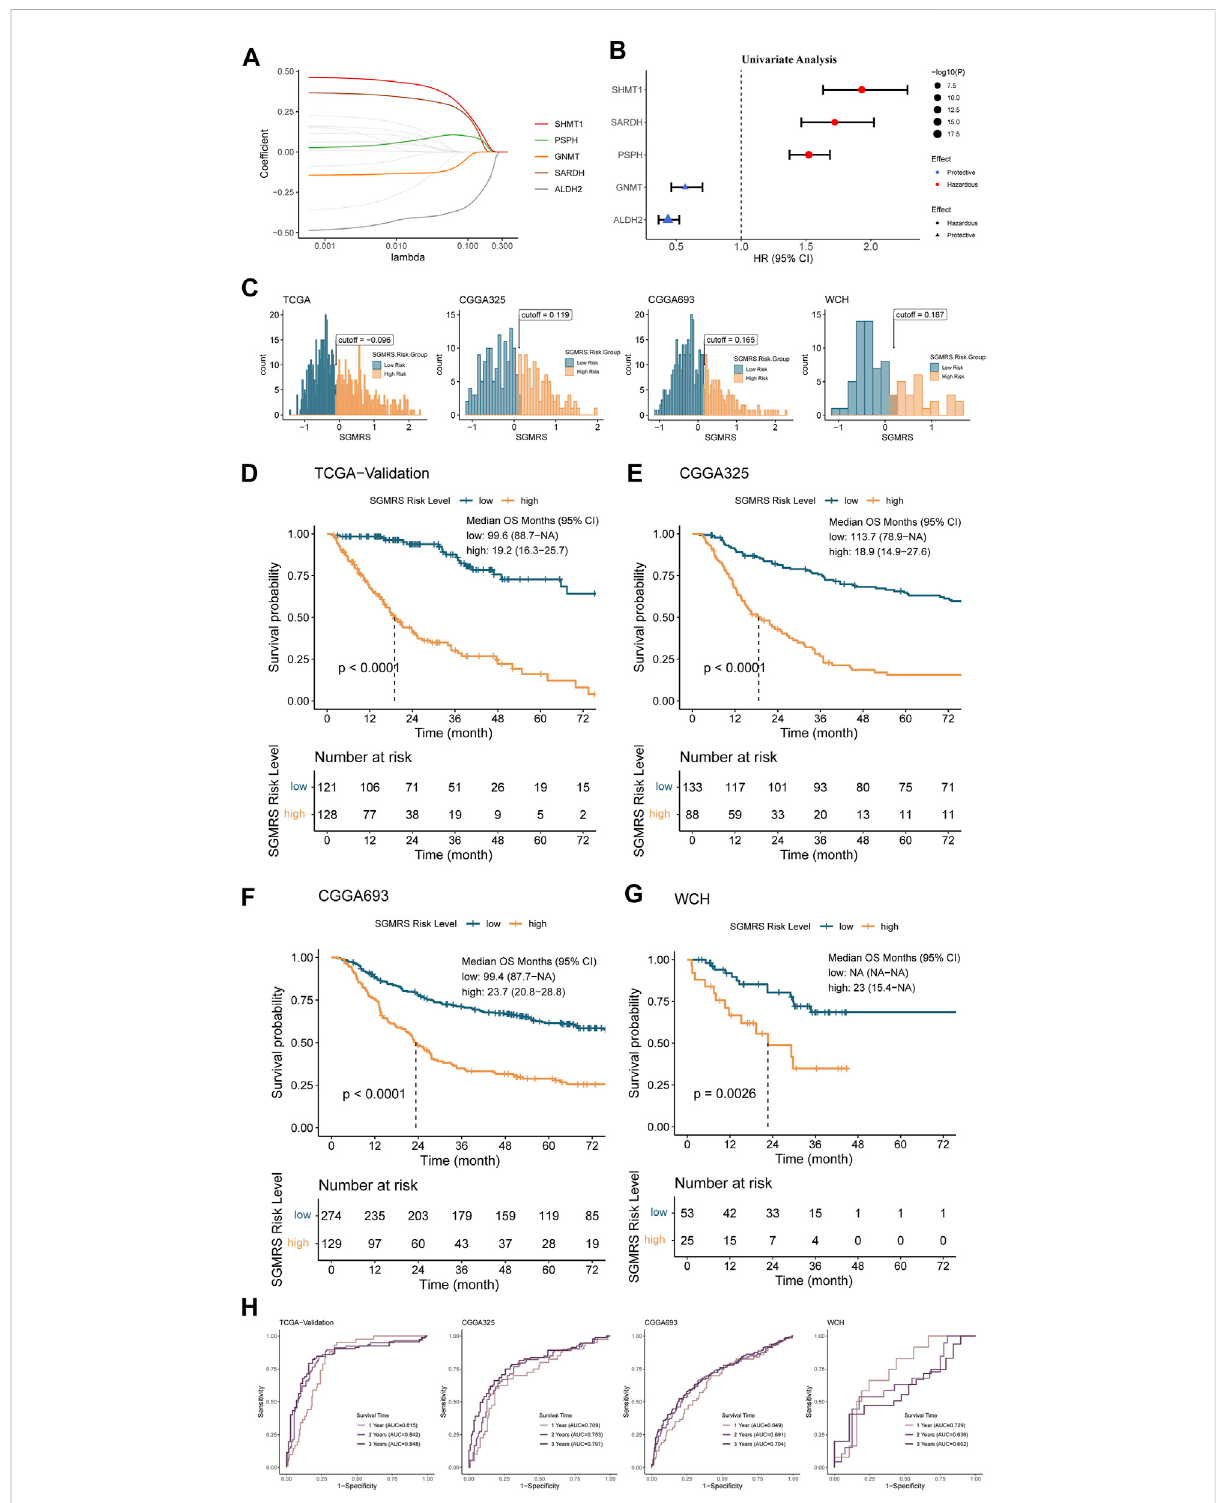
FIGURE 4 Construction of SGMRS and its relationship with prognosis. (A) Average of coef fi cients of fi ve critical SGMGs in the LASSO Cox regression at eachlambda value. (B) Theprognosticeffect ofeachcriticalSGMGinglioma. (C) Optima cutoff valueofSGMRS inall fourcohorts. (D) K-Mcurves of the (D) TCGA, (E) CGGA325, (F) CGGA693,and (G) WCHcohortsbasedonSGMRShigh-andlow-riskgroups. (H) ROCcurvesandmatchedAUCof1- , 2-, 3-year survival rate in all four